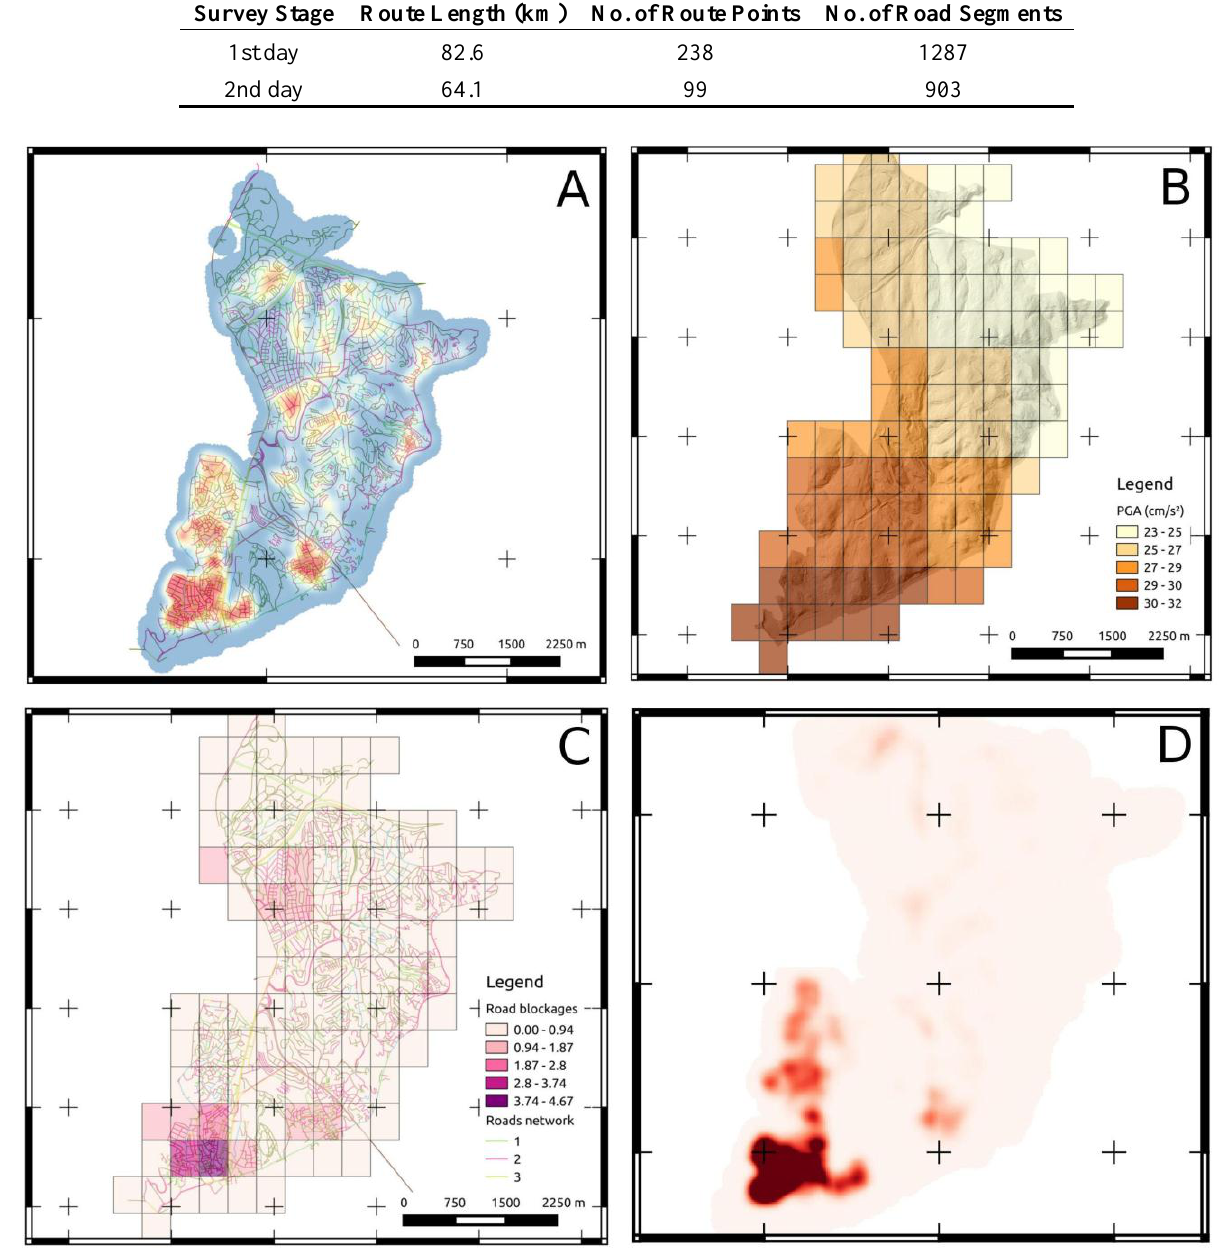
Table 3. Summary of 2-stage survey designed for Besiktas district.